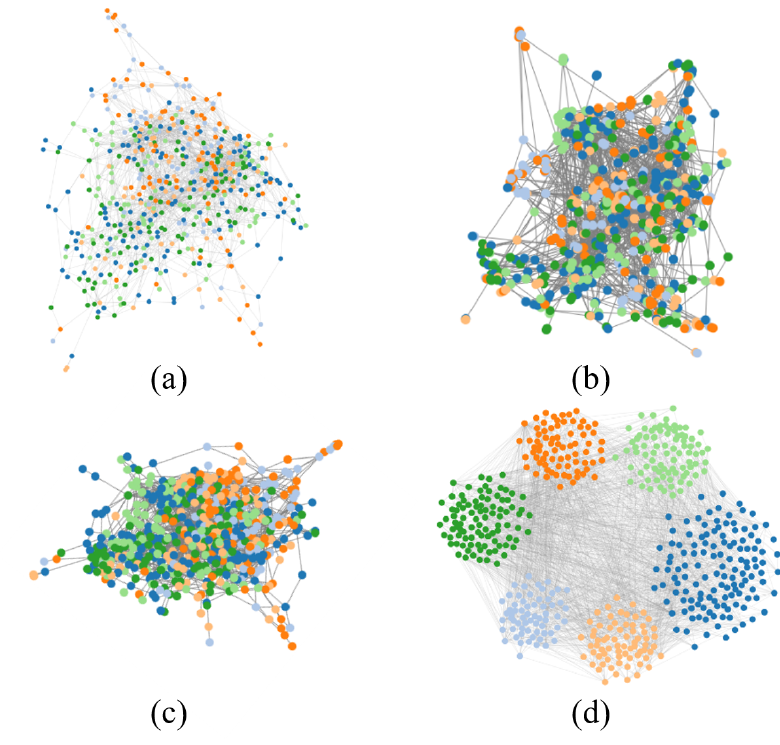
Figure 6. The result of attribute community layout under the attribute ‘Year’. ( a ) FR layout; ( b ) LinLog layout; ( c ) ForceAtlas2 layout; ( d ) layout of our method.